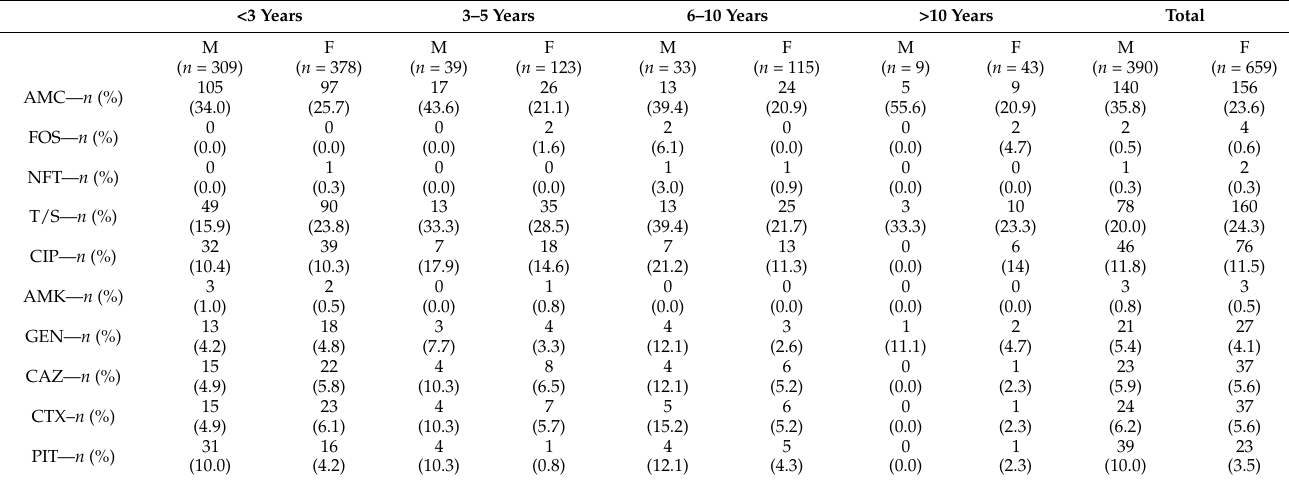
Table 1. Resistance rate of E. coli among different ages.